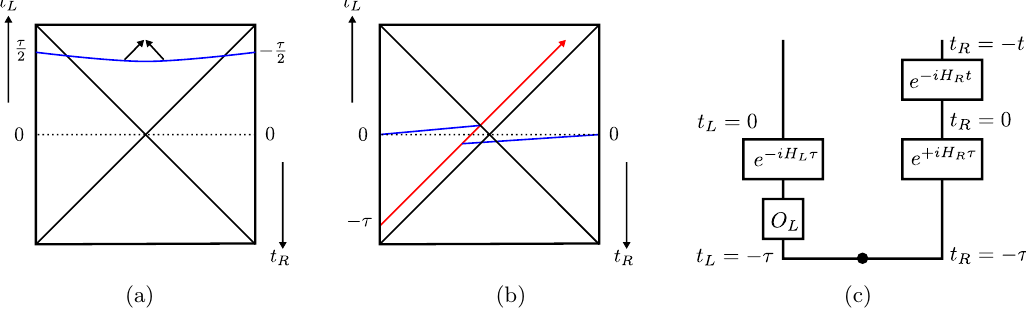
Figure 1 . (a) A maximal volume slice. A pair of bulk observers in the interior are shown. (b) A slice with a shock from the past t L = (cid:0) (cid:28) . (c) A circuit representation of a shockwave geometry. The horizontal line represents the TFD